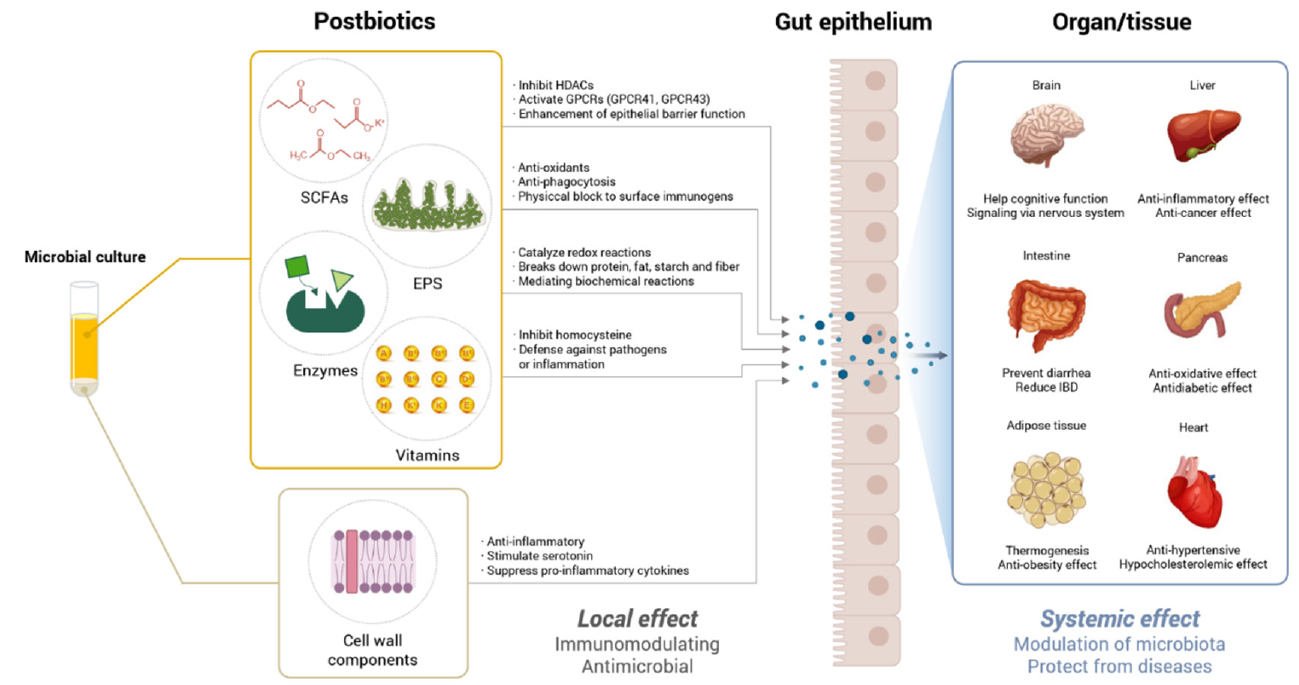
Figure 1. Schematic representation of various health benefits of postbiotic molecules in the host. EPSs, extracellular polymeric substances; GPCRs, G-protein-coupled receptors; HDACs, Histone deacetylases; SCFAs, short-chain fatty acids.